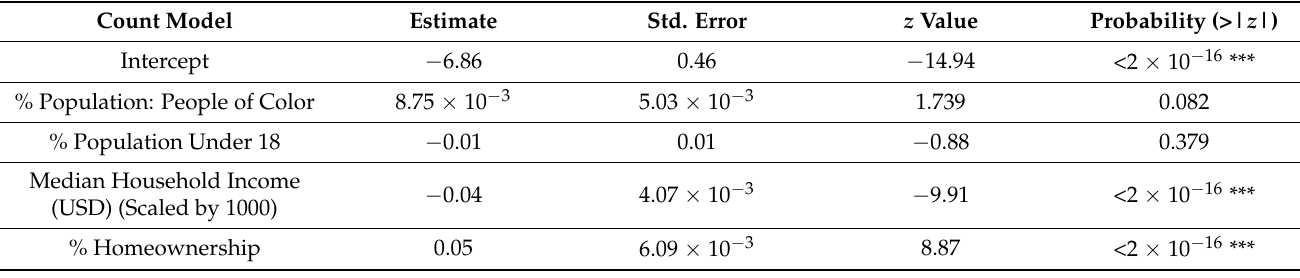
Table 3. Zero-inflated Poisson Regression Modeling for MD Chicken CAFOs.